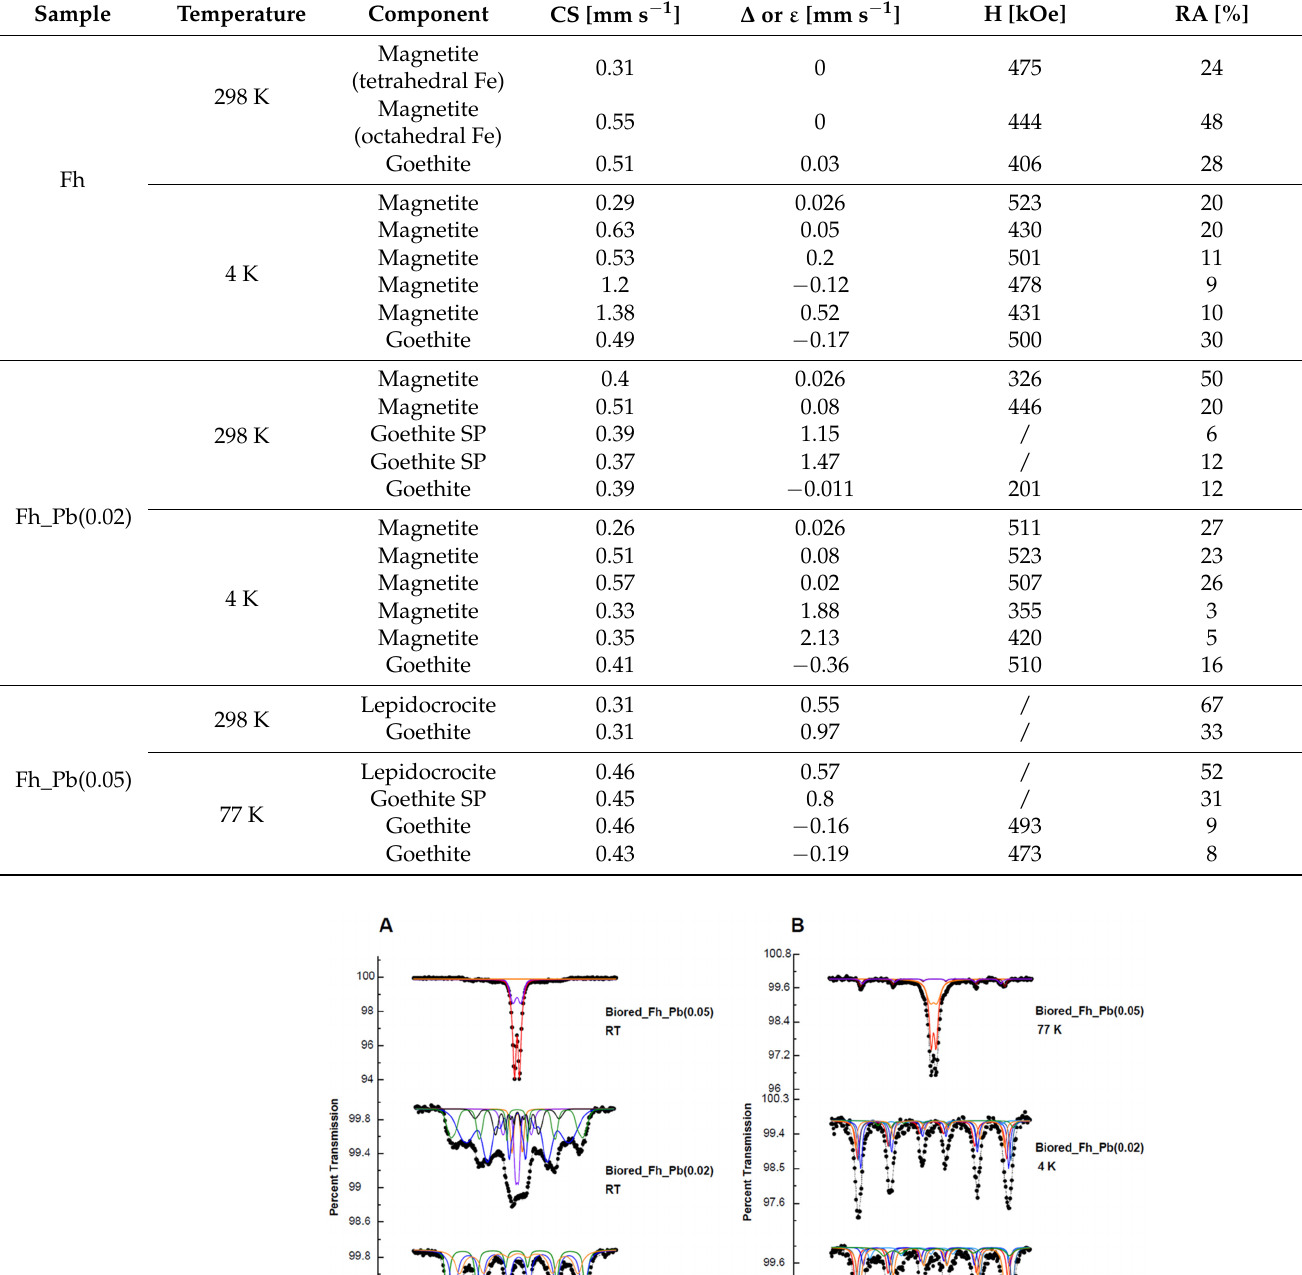
Table 2. Mössbauer hyperfine parameters of the spectra of the Fh, Fh_Pb(0.02), and Fh_Pb(0.05) secondary minerals obtained after the RP2 with Shewanella oneidensis MR-1, presented in Figure 5. CS: center shift relative to α Fe; ∆ : quadrupole splitting; ε : quadrupole shift; H: hyperfine magnetic field; and RA: relative area.